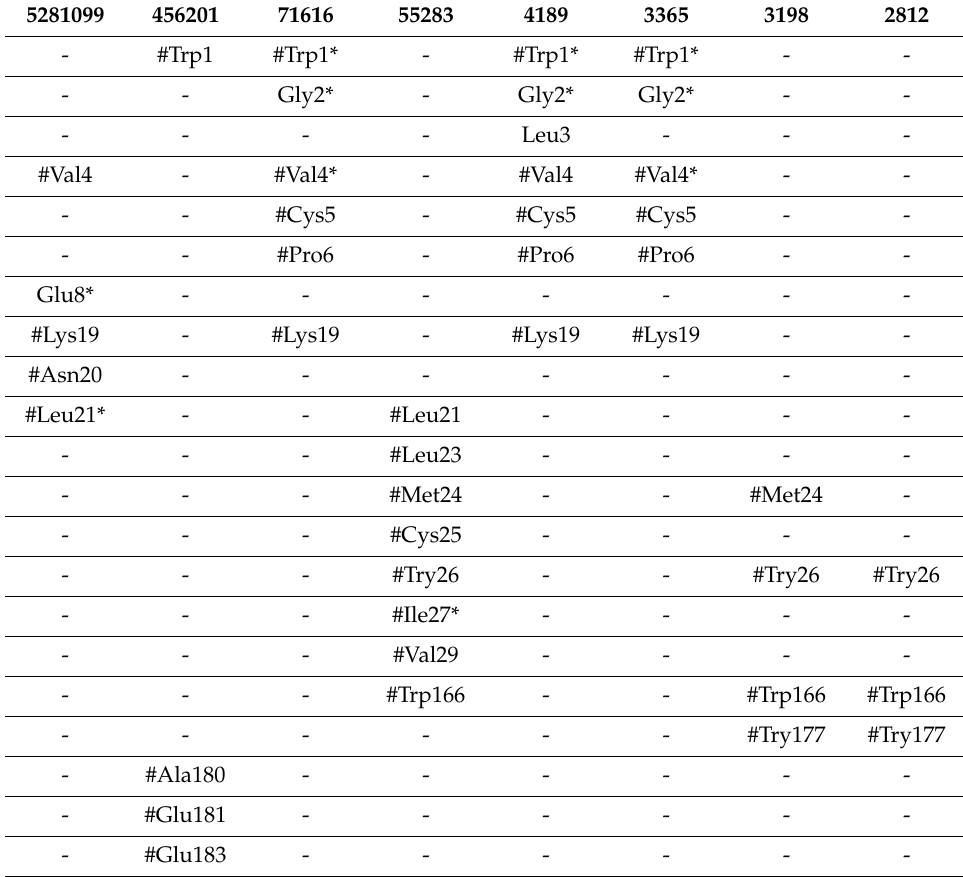
Table 4. Docking interactions of anti-fungal agents within the binding pocket of the modeled DNA dependent RNA polymerase II protein from Aspergillus fumigatus